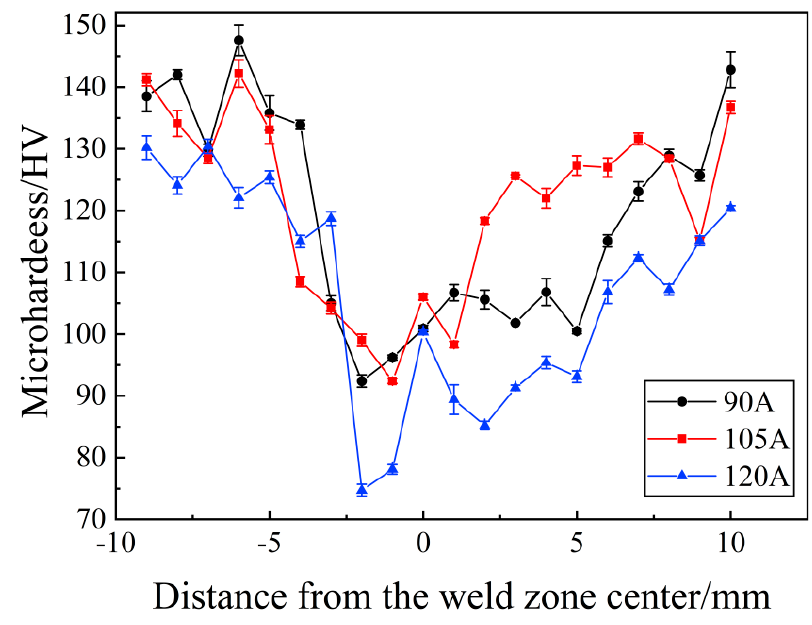
Figure 11. Microhardness of welded joints under different welding heat input.